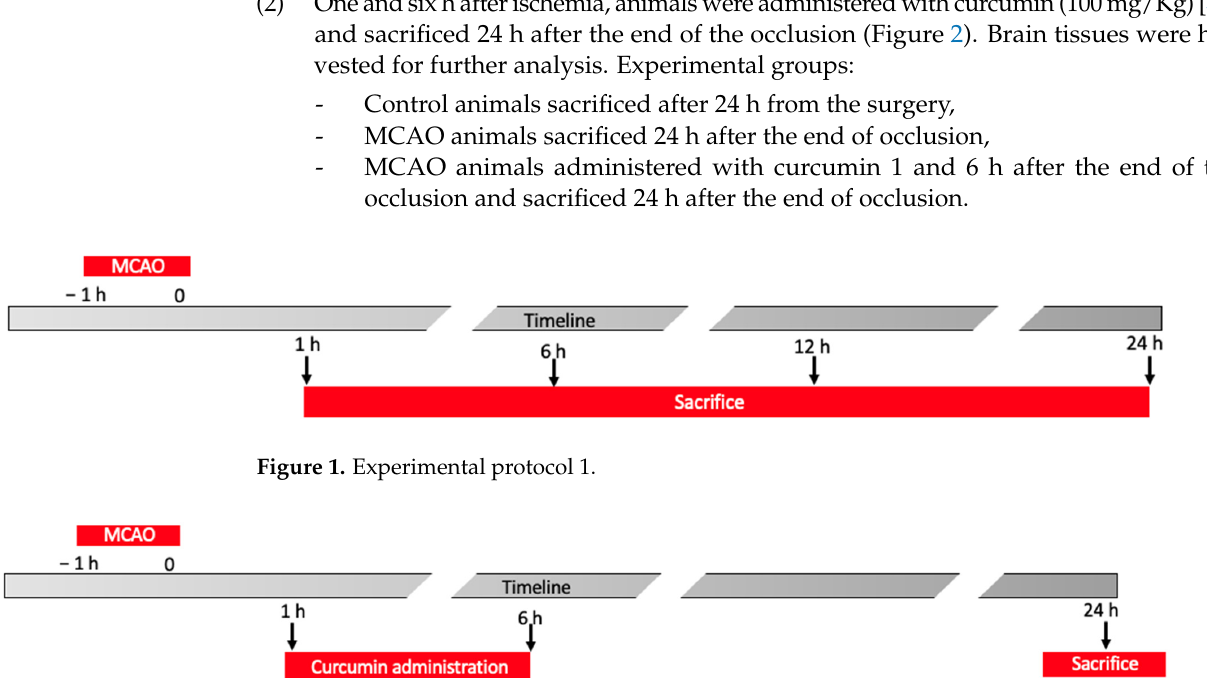
Figure 2. Experimental protocol 2.